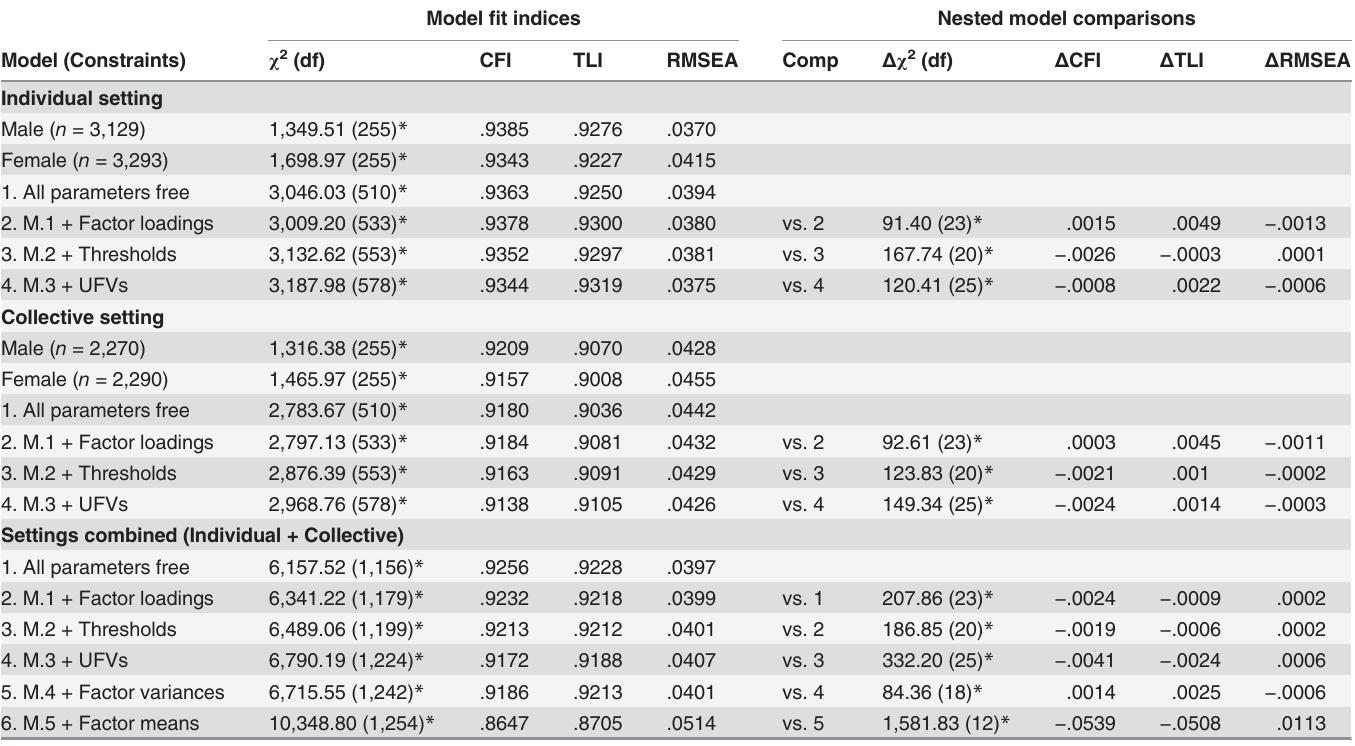
Table 3. Model fit and nested model comparisons for multiple-group CFA